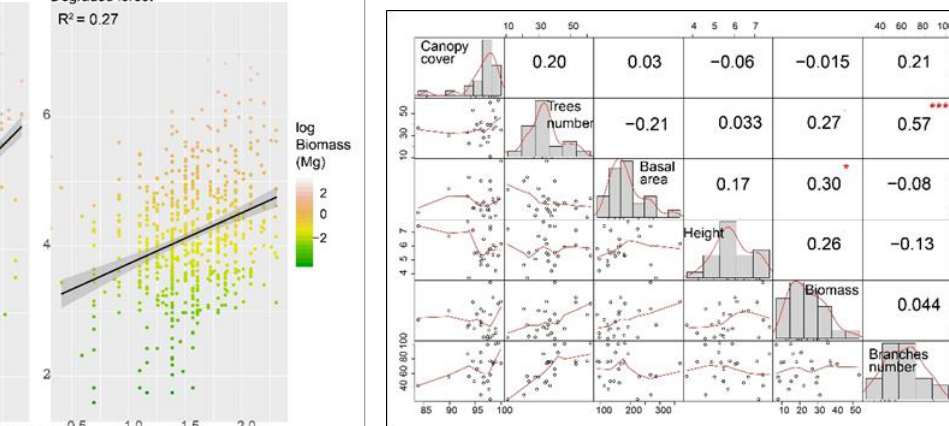
Figure 2. Correlation between logarithms transformed tree heights and their basal area at the individual trees level, in conserved forest and degraded forest.